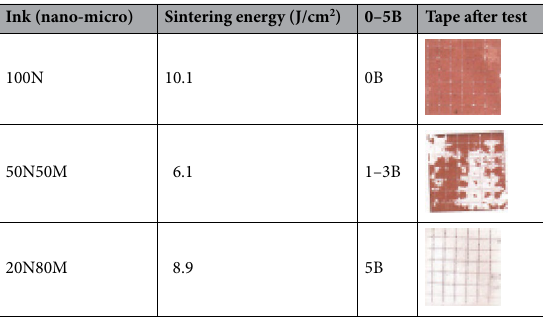
Table 3. Adhesion tape test